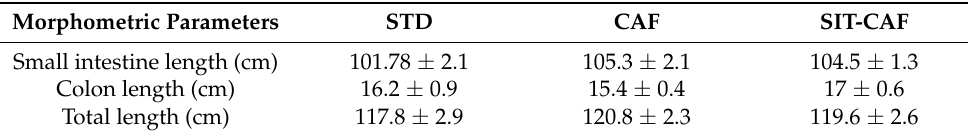
Table 3. Intestinal length in experimental groups at 17 weeks. STD group, rats fed standard chow diet; CAF group, rats fed cafeteria (CAF) diet; CAF-fed rats supplemented with a 500 mg kg − 1 b w of GSPE. The number of animals included in this study was n = 10 for each group. Values indicate mean ± standard error